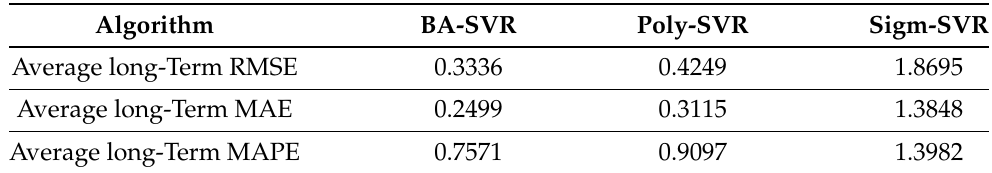
Table 13. Comparison of long-term forecast